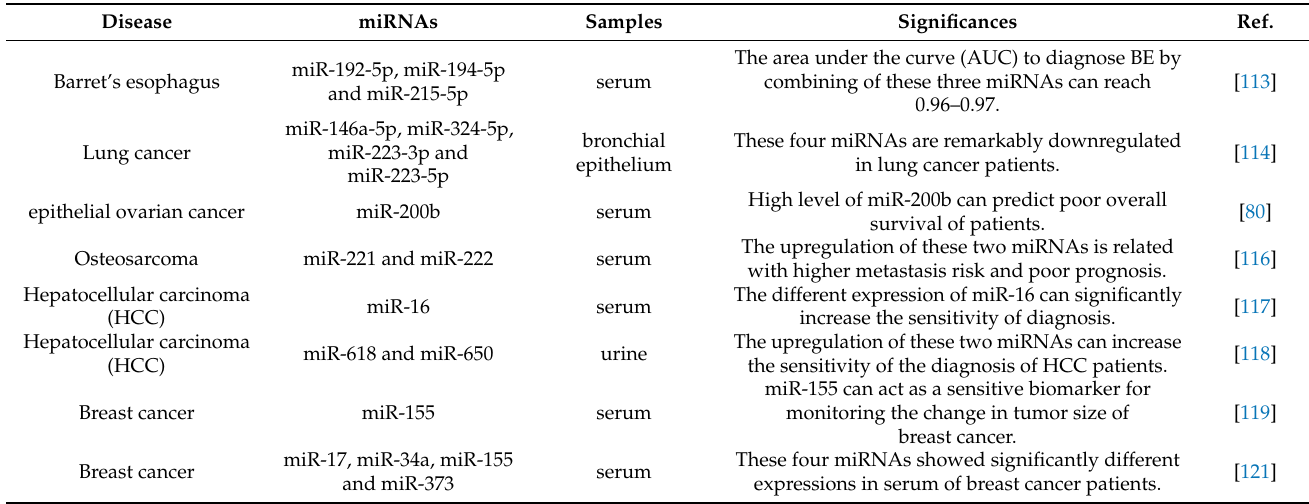
Table 2. miRNAs with diagnostic potential in